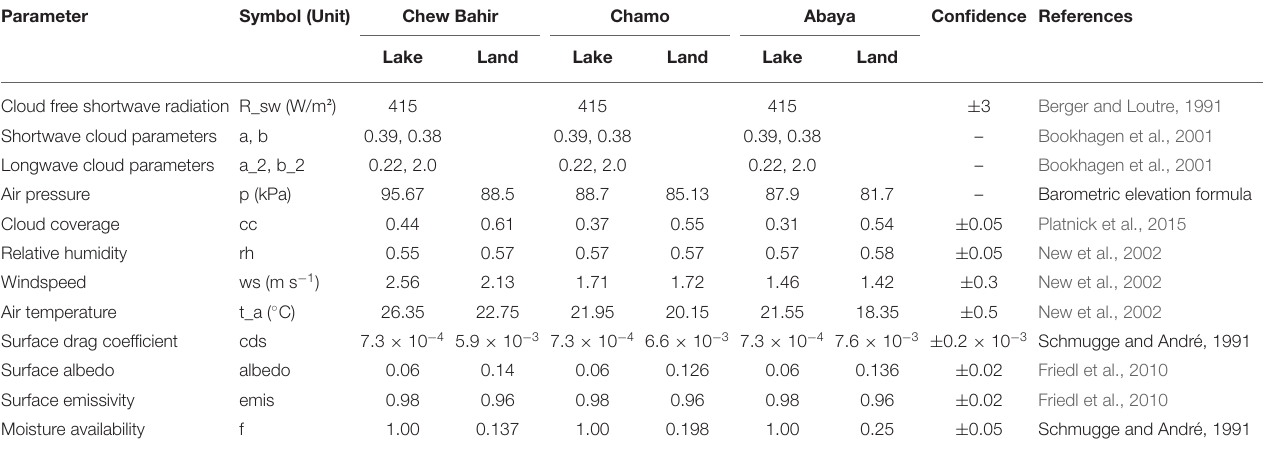
TABLE 1 | Summary of input parameters for the LBM of Chew Bahir, Chamo, and Abaya.